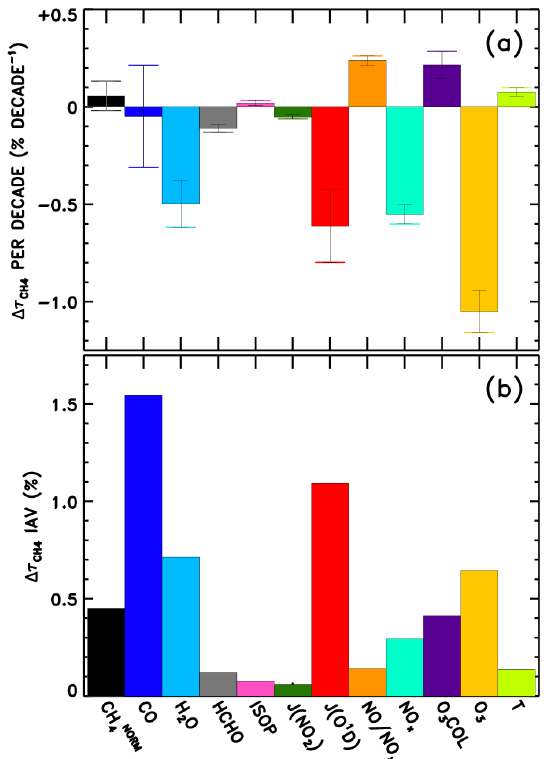
Figure 9. Multi-model mean linear trend (a) and interannual vari- ability (b) in τ CH attributed to each variable examined through the 4 NN